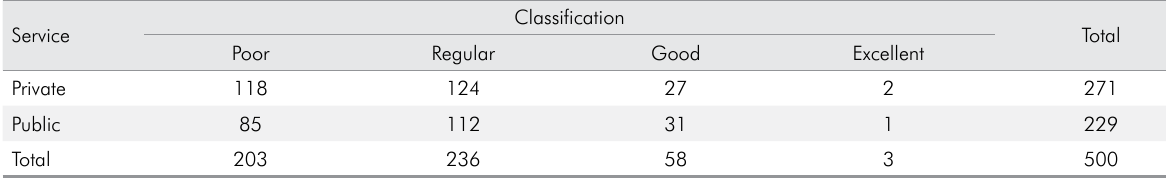
Table 3. Classification of referral letters according to the origin .